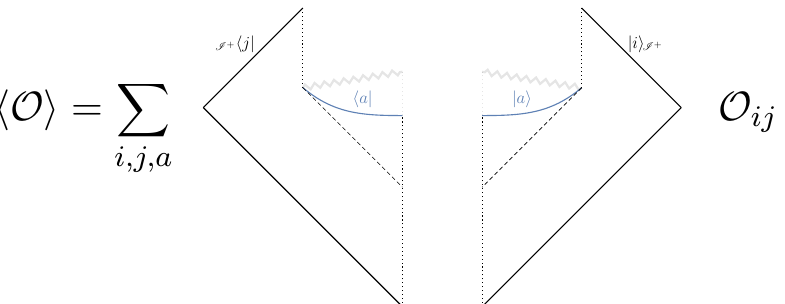
Figure 18. Cutting the Hawking wormhole computing the expectation value of an operator O defined on I + (with matrix elements O ij = I + h i |O| j i I + ) to obtain a Hilbert space interpretation. The path integral on the right spacetime, with boundary conditions on I + set by the state | i i I + and on Σ int by the state | a i , computes the wavefunction ψ ai of a pure state in H I + ⊗ H int . The left spacetime computes the conjugate wavefunction, and to obtain the expectation value we sum ¯ ψ over all intermediate states, hOi = P aj ψ ai O ij i,j,a